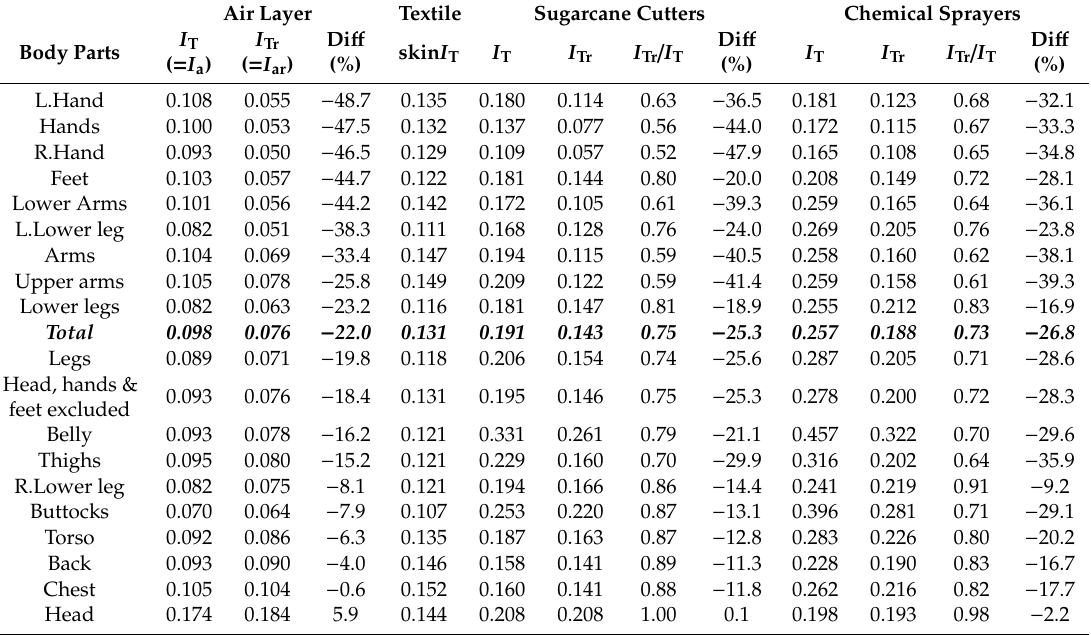
Table 2. Total and total resultant insulation of the whole body, body regions and individual zones (m 2 K / W) with percentual di ff erences between static ( I T ) and dynamic ( I Tr ) values. Air Layer Textile Sugarcane Cutters Chemical Sprayers Body Parts